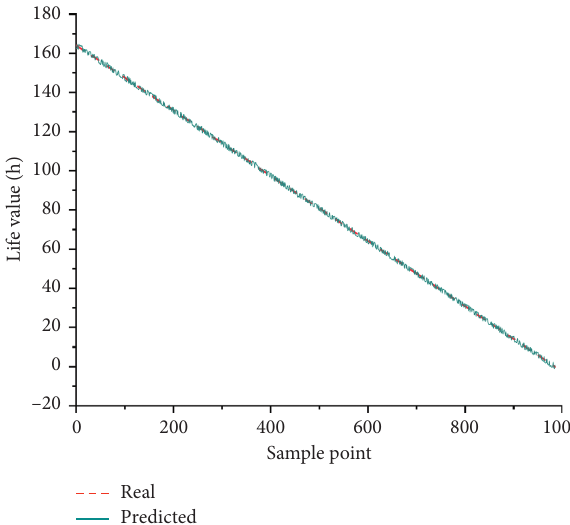
Figure 7: Comparison of the life values of all samples.